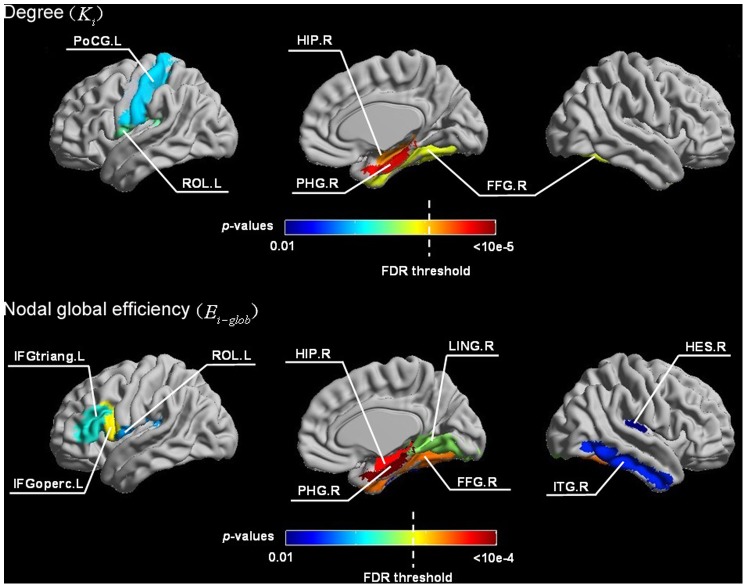
Locations of the cortical regions showing statistically significant differences in two nodal parameters,  and , of the anatomical networks.The lower panel shows the differences in the nodal global parameter (), and the upper panel shows the differences in degree () of the anatomical networks. The dotted white line shows the critical FDR threshold (q = 0.05; see Materials and Methods). Most of the significantly different regions were in the brain medial plane. In these regions, the values of these two nodal parameters were higher in the anatomical networks derived from the FLAIR-DTI datasets than those derived from the conventional DTI datasets.